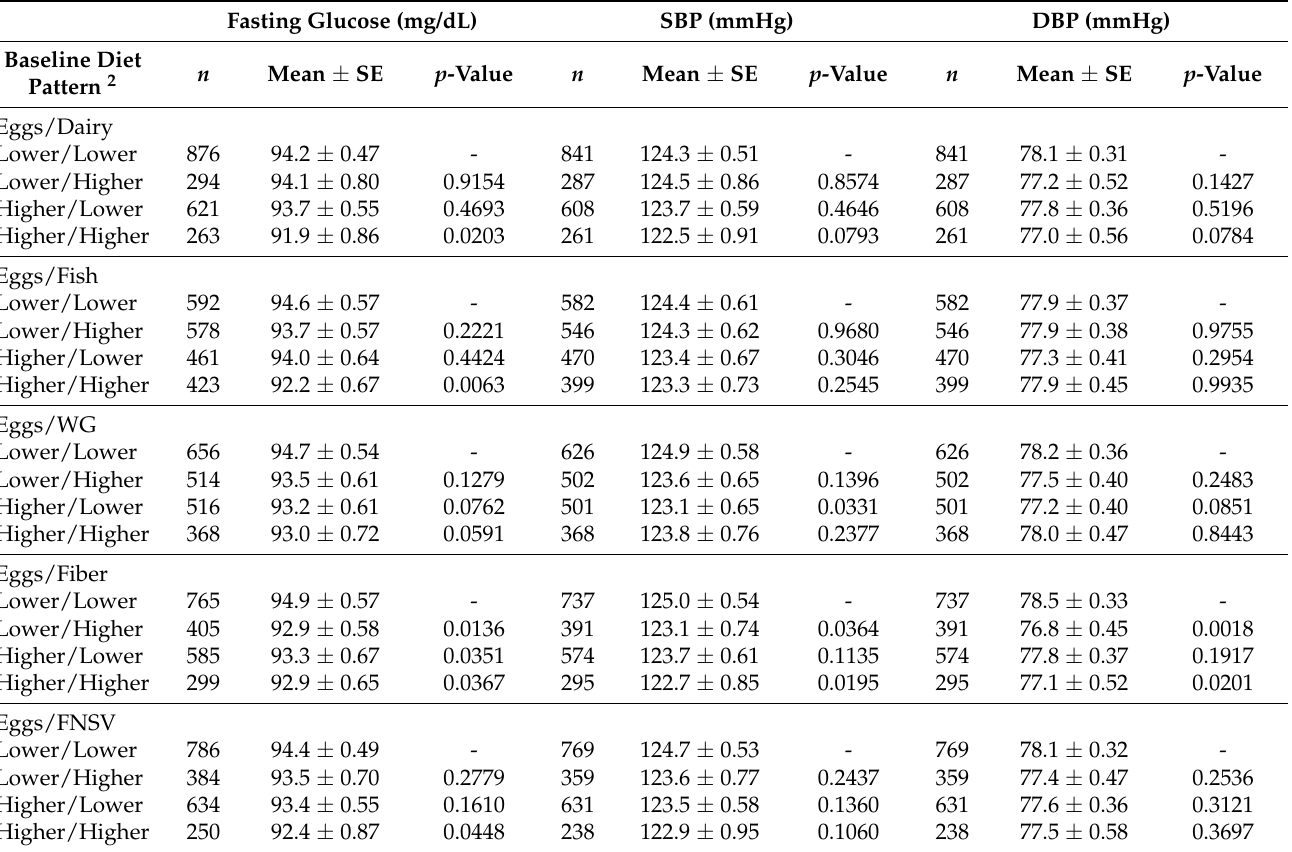
Table 3. Effects of egg intake as part of healthy patterns on mean fasting glucose and blood pressure levels after four years of follow-up 1